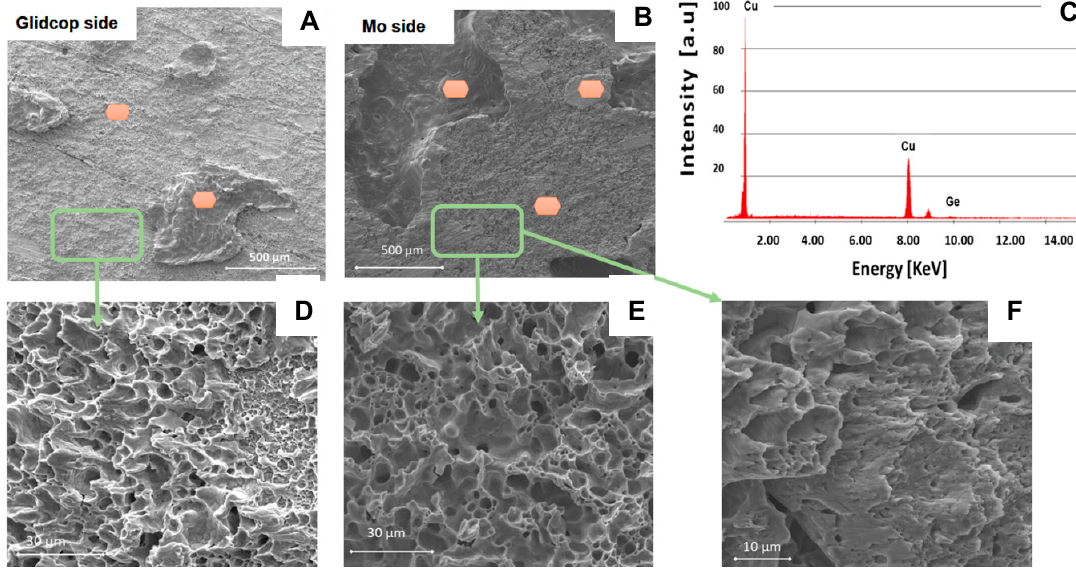
Figure 10 . SEM and EDS analysis on Glidcop and Mo fracture surface apparent shear test according to ASTM B898-11; on both surfaces only Cu and Ge have been detected, thus indicating that cracks propagate within the braze and in some areas close to or in Glidcop; the EDS spectrum refers to measurements done in all the orange areas. ( A ) fracture surface of Glidcop side; ( B ) fracture surface of Mo side; ( C ) EDS analysis on orange areas of fracture surfaces shown in ( A , B ); ( D ) magnification of fracture surface area on Glidcop side; ( E ) magnification of fracture surface area on Mo side; ( F ) higher magnification of area shown in ( E ).